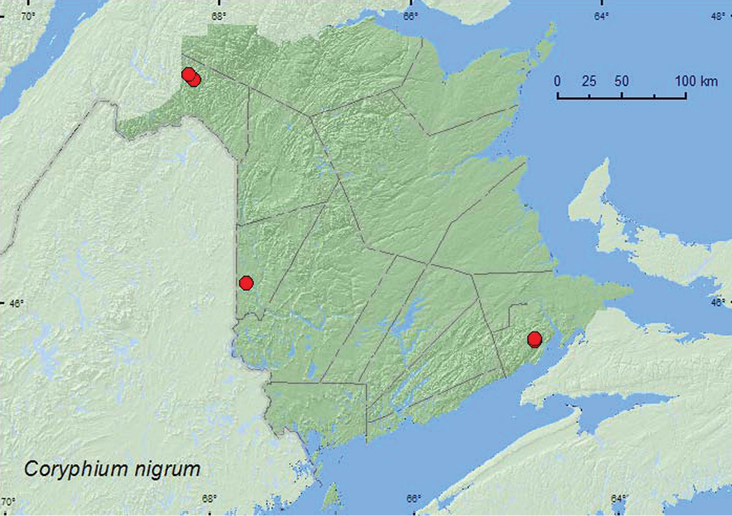
Collection localities in New Brunswick, Canada of Coryphium nigrum.